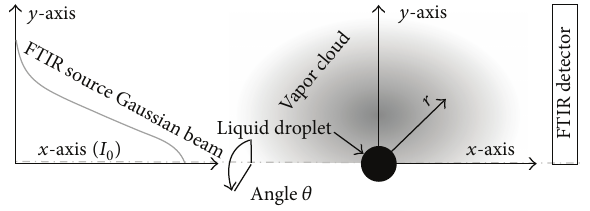
Figure1:Two-dimensionalrepresentationoftheabsorptionprocess used to derive the model presented here. Note that 𝜃 is the angle of revolution and that the beam moves from left to right in this